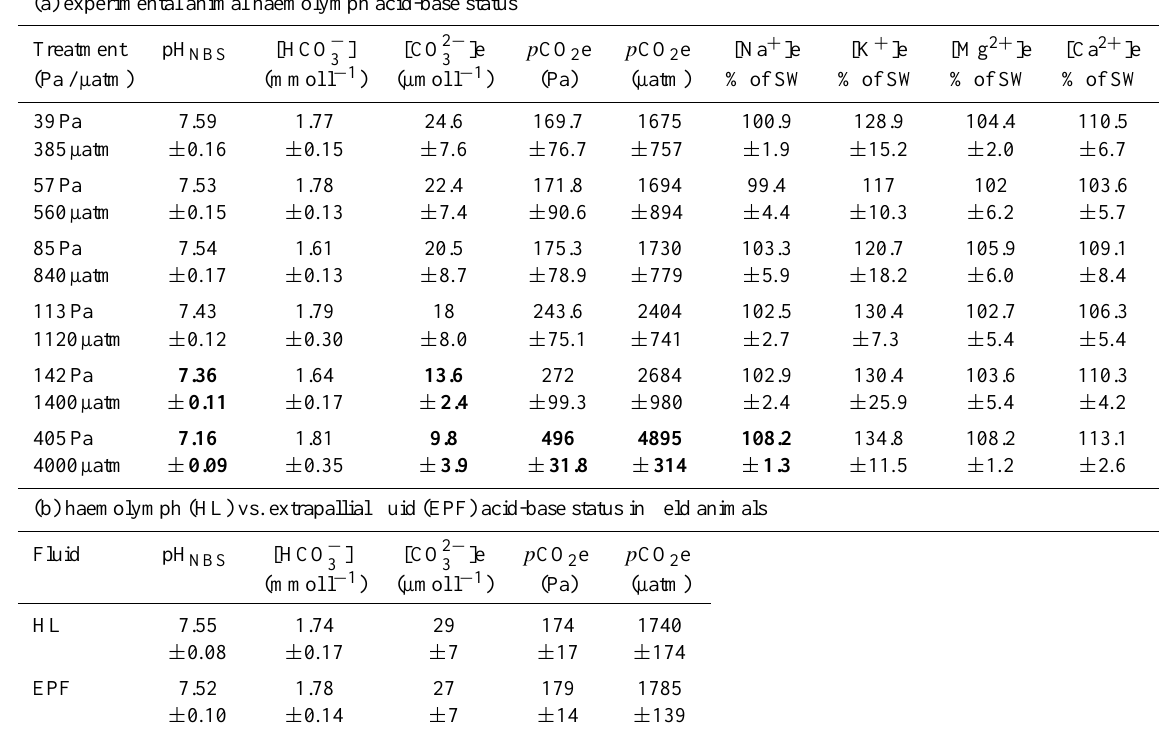
Table 3. (A) Exp. 1 haemolymph acid-base status and ion concentrations of large mussels in relation to treatment p CO 2 . Significant differences from control (39Pa, 385µatm treatment) in bold, mean values ± SD. (B) Haemolymph (HL) vs. extrapallial fluid (EPF) acid- base status in 11 mussels sampled from Kiel Fjord at an ambient seawater p CO 2 of 50Pa (493µatm) (30 August 2010) at T = 15.7 ◦ C, S = 14.6, pH NBS = 7.89 during the main growth period in this